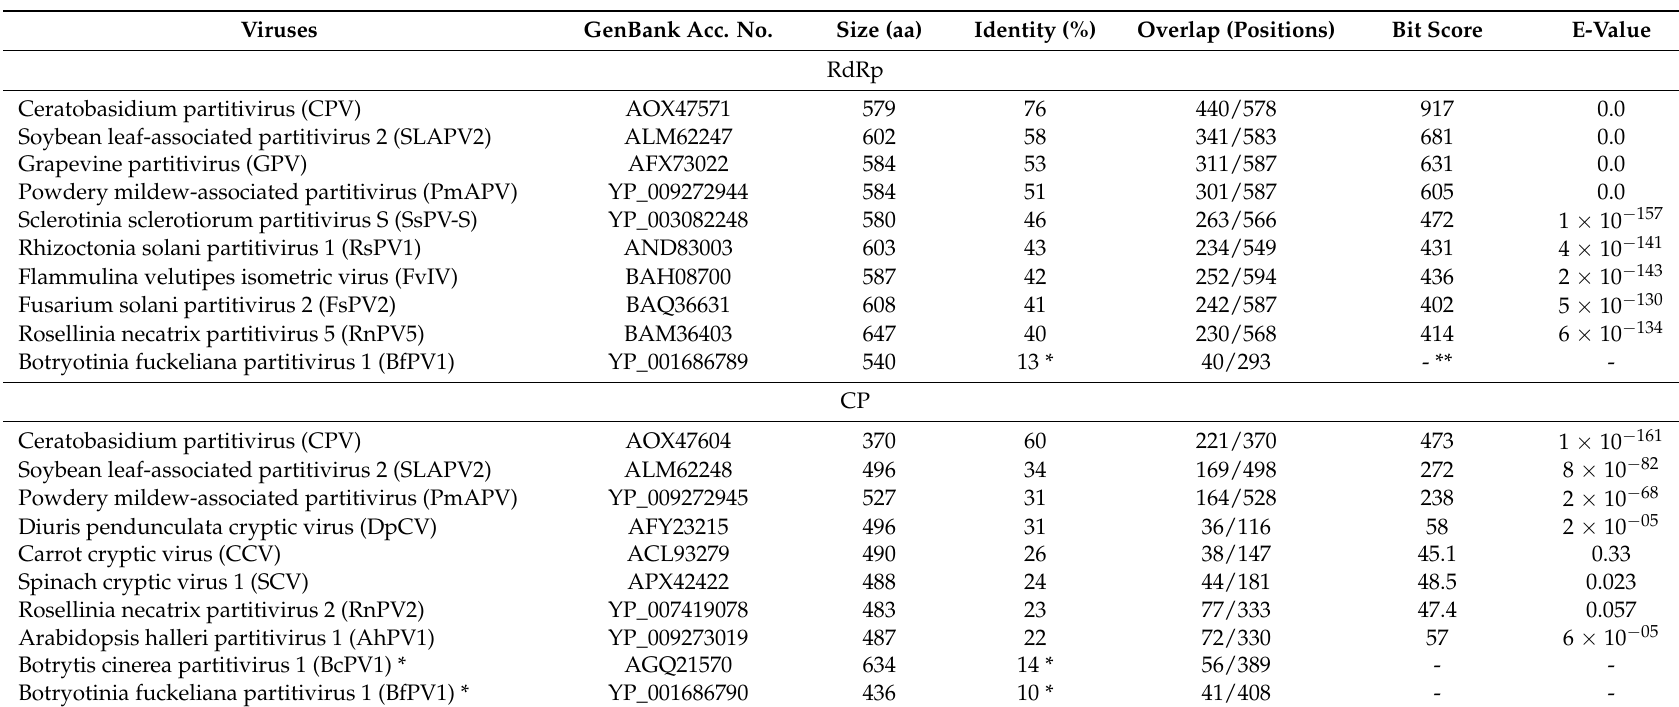
Table 1. Summary of the results in the BLASTp search for RNA-dependent RNA polymerase (RdRp) and coat protein (CP) of Botrytis cinerea partitivirus 2 (BcPV2). Viruses GenBank Acc.